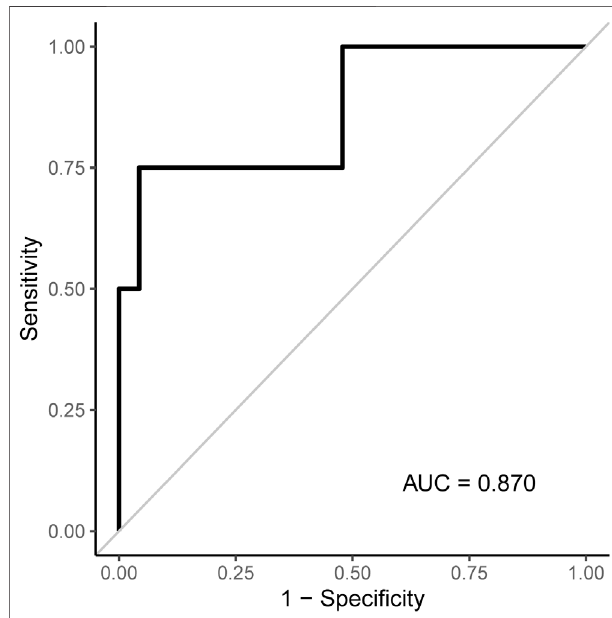
FIGURE5 | ROC curve associated with the logistic regression model for osteoporosis shown in Table 2 . An L1 density threshold of ≤ 106 to indicate osteoporosis maximizes the sum of sensitivity and speci fi city within this data.